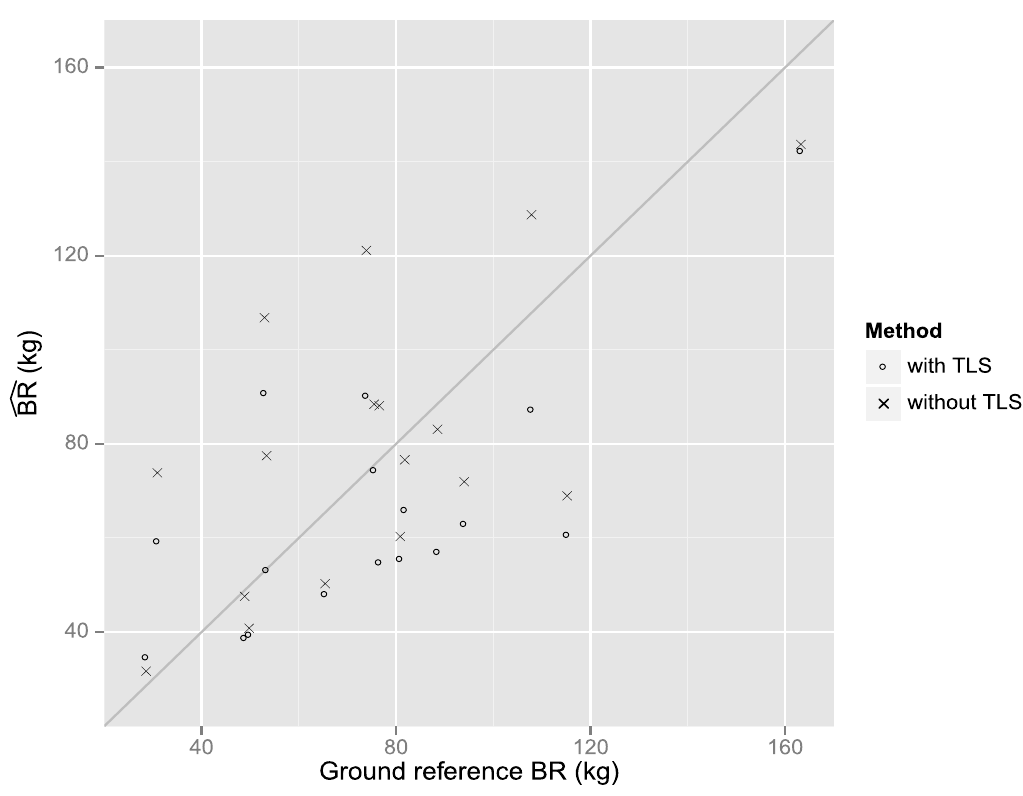
Figure 6. Predicted ( ) versus ground reference crown biomass (BR) in the validation of the two approaches for the prediction of crown biomass.